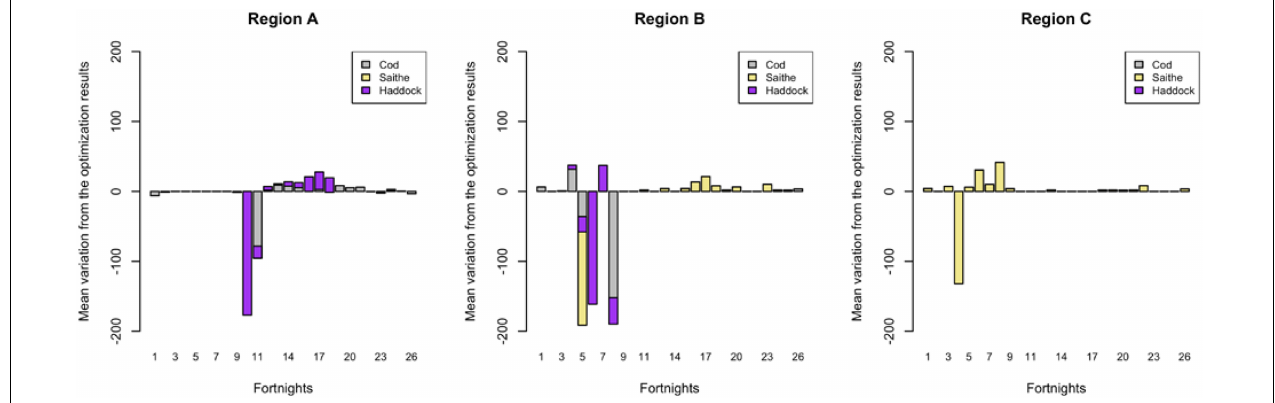
FIGURE 10 | Mean variation from the optimization result. The numbers on the y -axis show the difference between the mean value of 100 Monte Carlo simulations and the main result presented in the